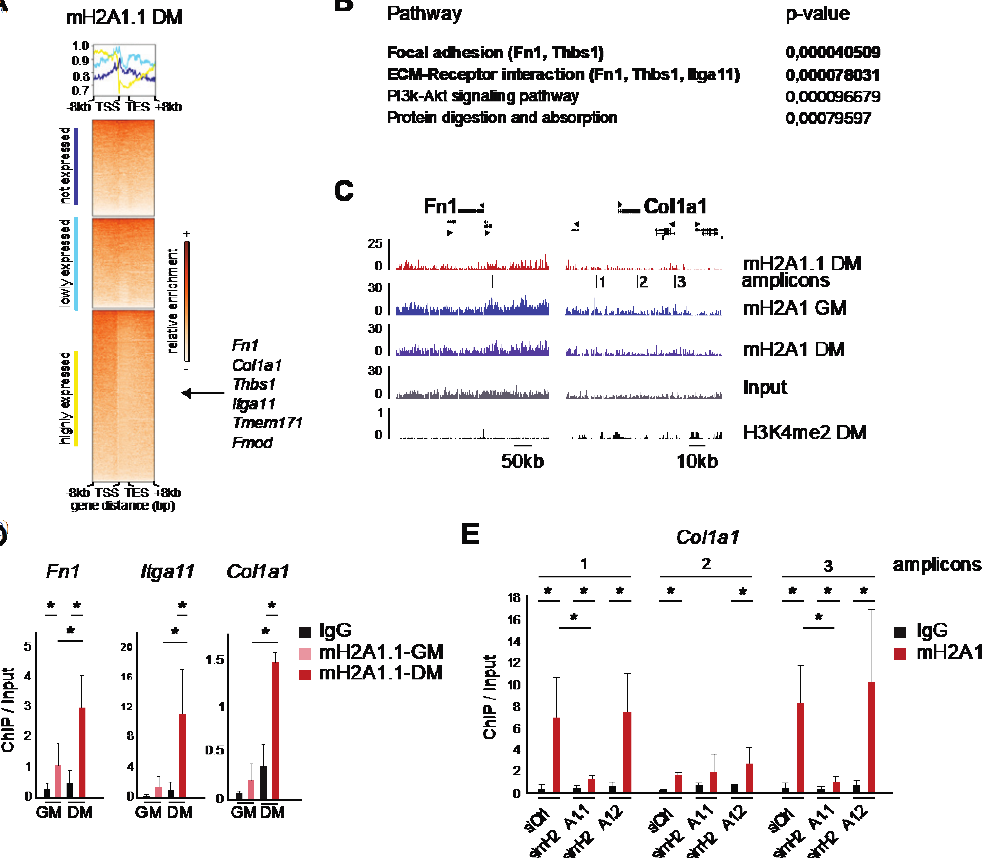
Figure 5. MacroH2A1.1 (mH2A1.1) occupies fusion-related genes in myotubes. ( A ) Heatmaps and summary plots using normalized read coverages from mH2A1.1 ChIP-seq from myotubes after four